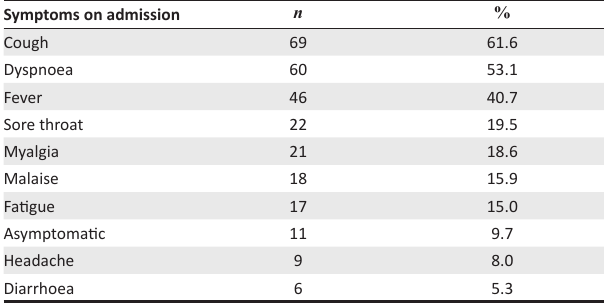
TABLE 1a: Symptoms on admission ( n = 113).